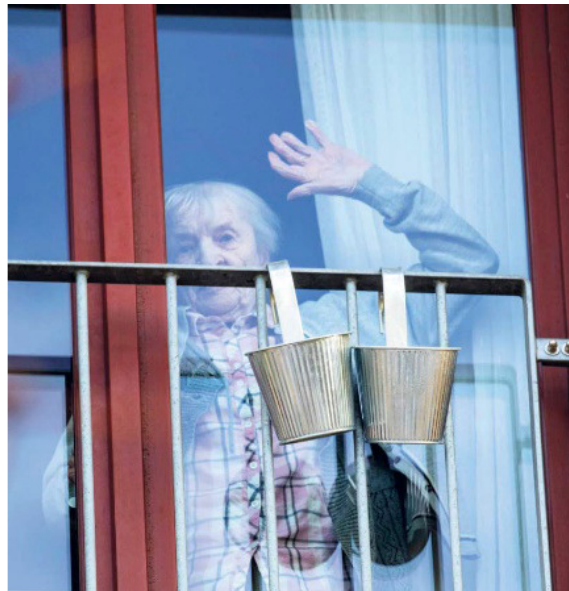
Figure 1. Image of the suffering old women in isolation. Source: Neugebauer & Dombrowski (2020, p.